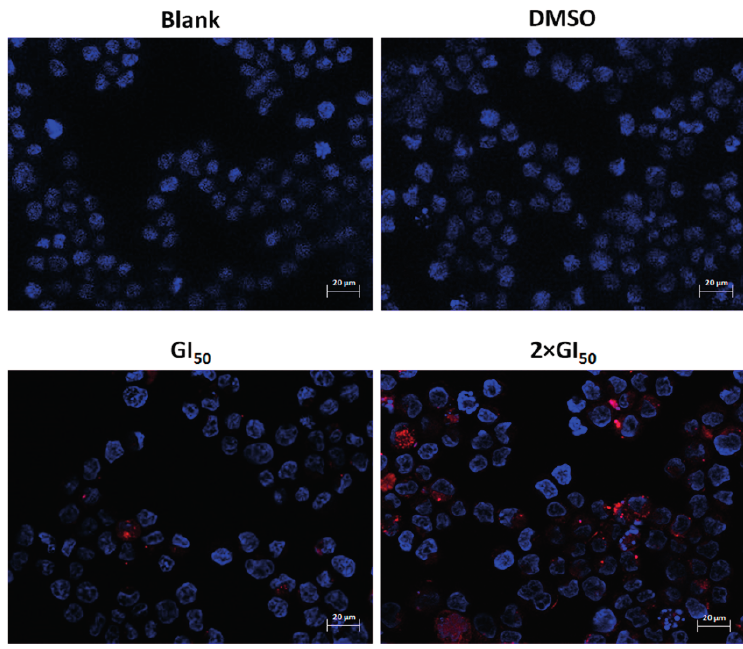
Figure 2. Analysis of the presence of autophagic vacuoles following treatment with G. lucidum methanolic extract, by fluorescence microscopy. Cells were transfected for 24 h with LC3 mCherry vector ( red ) and further treated for 48 h with: medium only ( Blank ), with the methanolic extract (at GI 50 and 2 × GI 50 concentrations) or with the extract solvent (DMSO) corresponding to the higher concentration of the extract. Nuclei were stained with DAPI ( blue ). Images are representative of two experiments. Bar corresponds to 20 μ